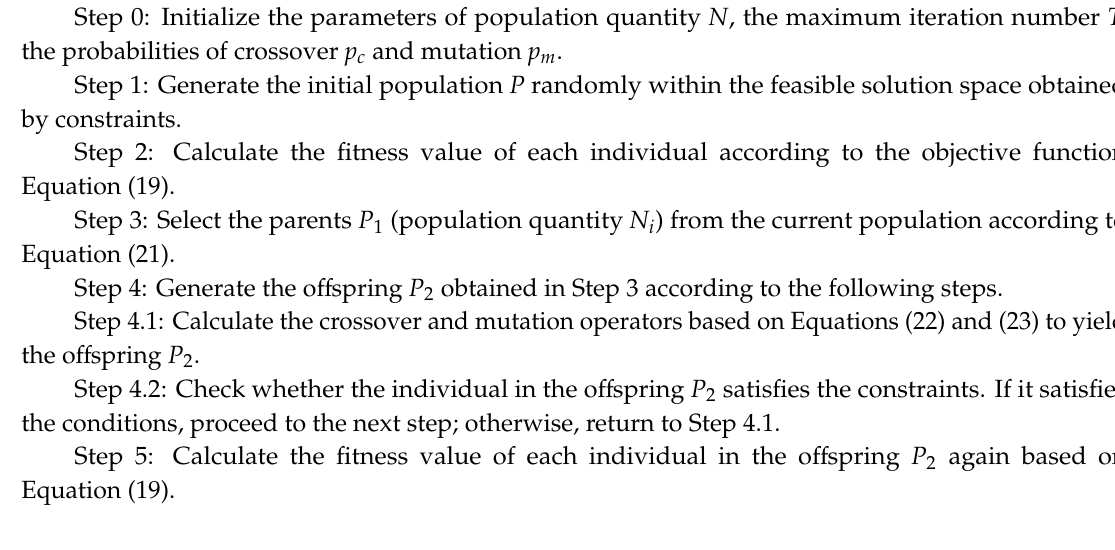
Figure 4. Flow chart of the improved genetic algorithm (IGA).